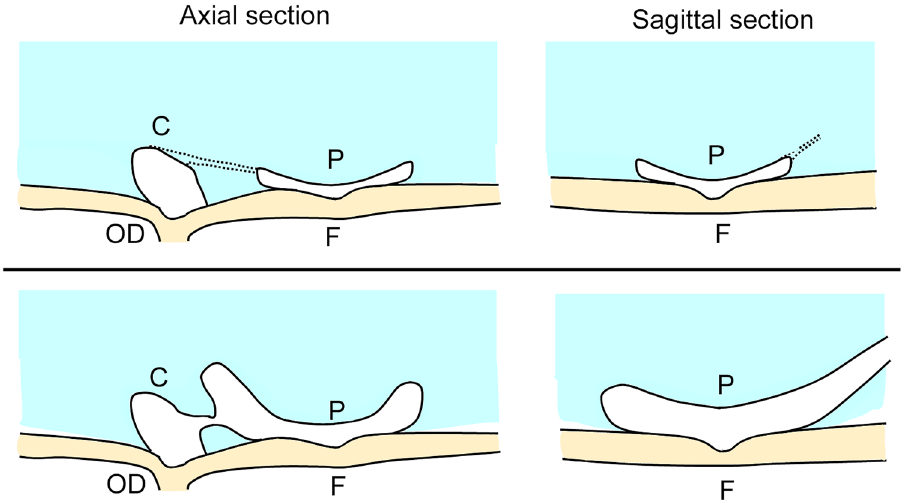
Figure. 4. Schematic diagram showing the course of the expansion of the vitreous fluidic cavities and the development of connections between the cavities. Top row: at birth, Cloquet’s canal (CC) and a small premacular vitreous cavity are present on the retinal surface. These cavities are connected by narrow canals as seen in the axial sectional image. On the sagittal section image, the superior boundary of the premacular vitreous pocket (PMP) is lifted-up and the narrow canal extends anteriorly. Bottom row: with increasing age, the fluidic cavities expand and the PMP develop. The connection between PMP and CC is also seen in the axial sectional images. In the sagittal sectional image, trunk-like fluidic space can be seen to expand anteriorly from the superior edge of the PMP. C Cloquet’s canal, P premacular vitreous pocket, F Fovea, OD optic